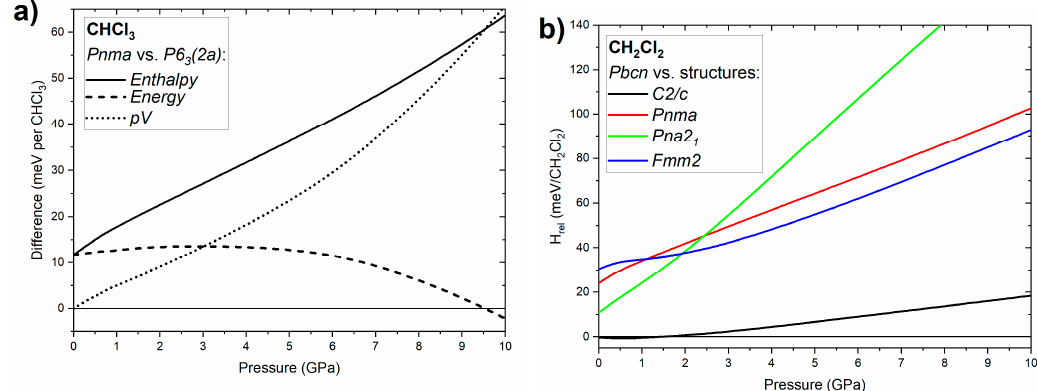
Figure 5. ( a ) Pressure dependence of the enthalpy, energy and p · V term of the P6 3 (2a) structure of CHCl 3 with respect to the Pnma phase; ( b ) pressure dependence of the enthalpy of the C2 / c , Pnma , Pna2 1 , and Fmm2 structures of CH 2 Cl 2 with respect to the Pbcn phase.